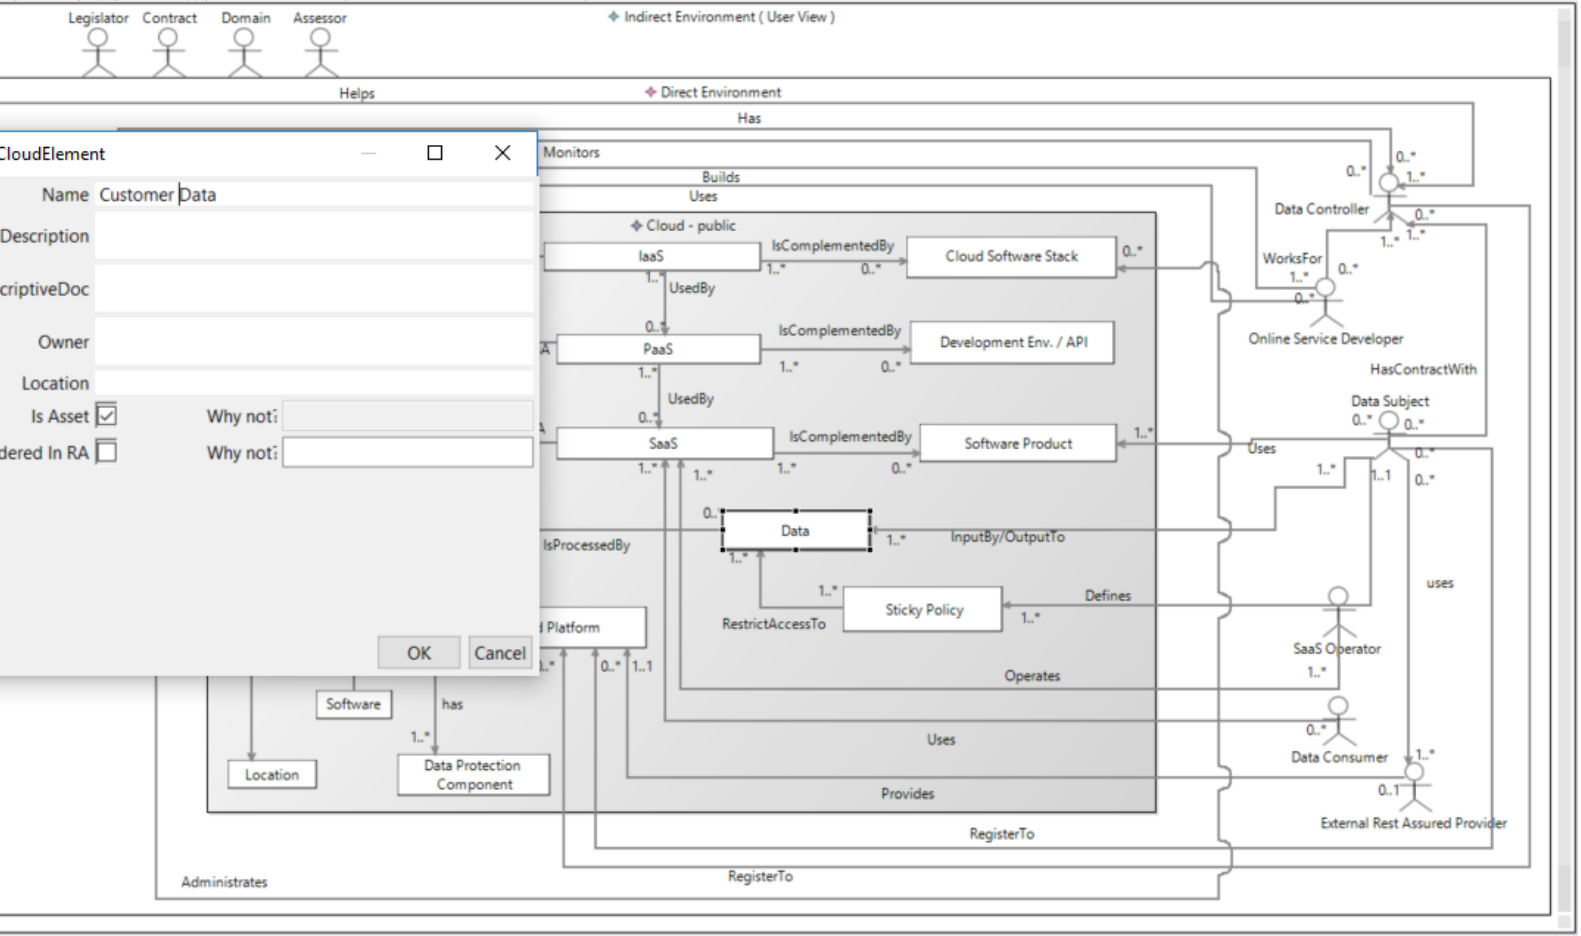
Figure 9. Instantiation of a cloud element of the data instance type in a